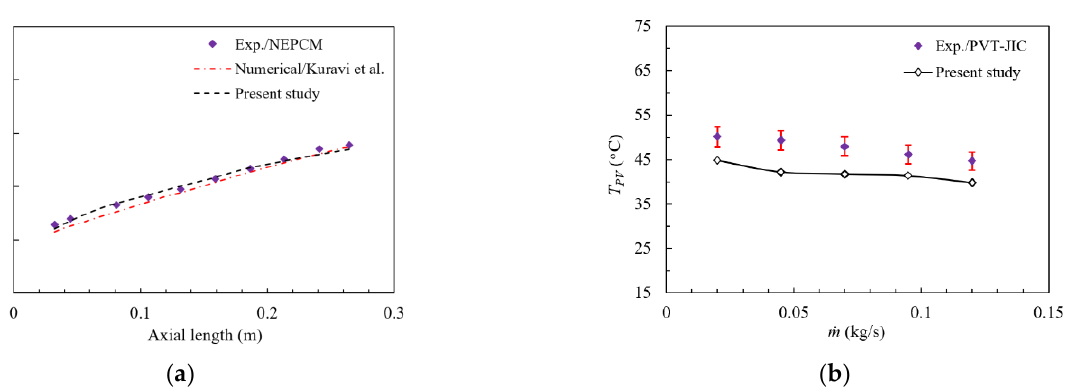
Figure 2. Validation of the present study. ( a ) Validation with the Exp. [33] and numerical [26] data, and ( b ) validation with PV/JIC experimental data [2].